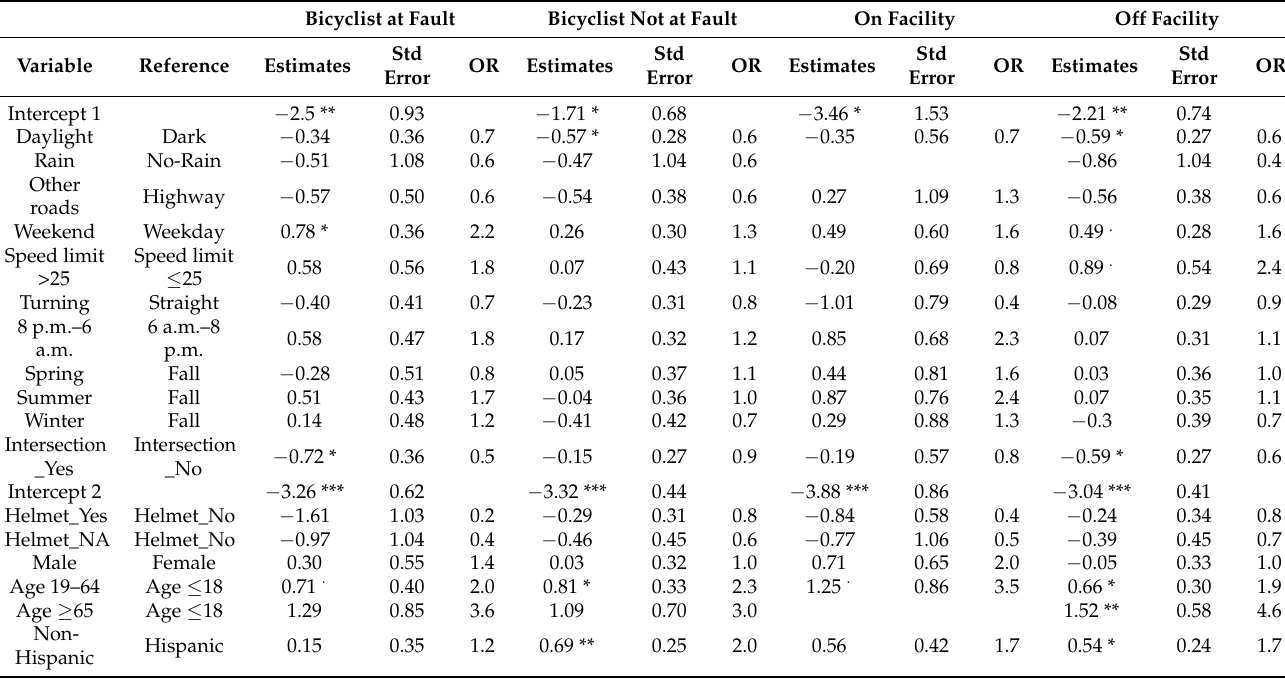
Table 5. Logistic regression model results for severe injury (KA) based on party at fault and bicycle facility